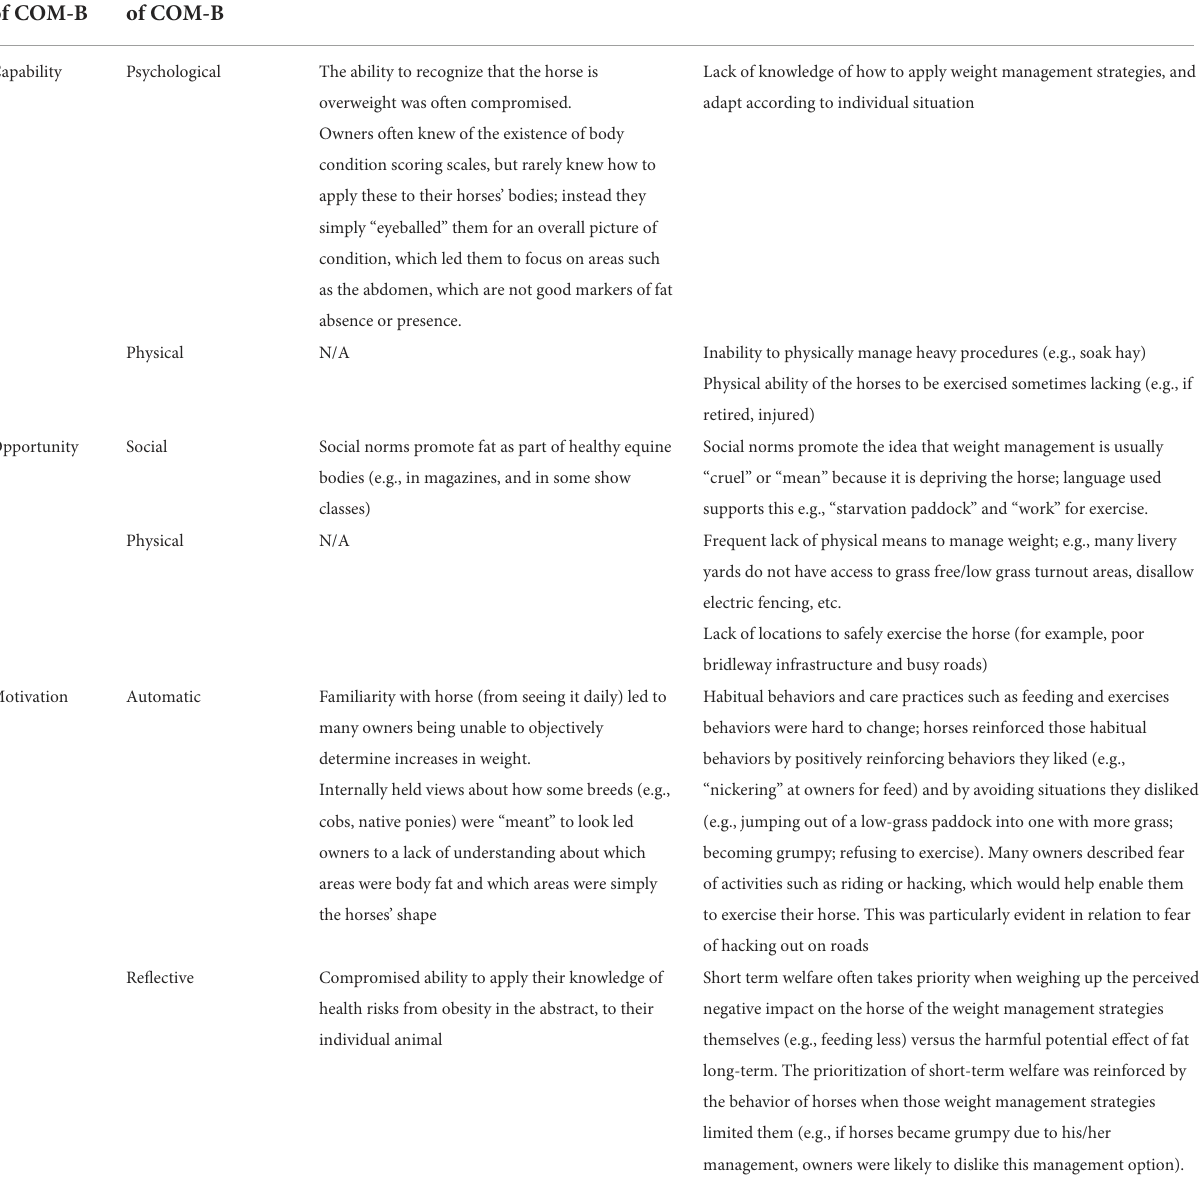
TABLE 2 Application of COM-B components to two relevant aspects in equine obesity: Recognition of equine overweight, and management of equine weight.